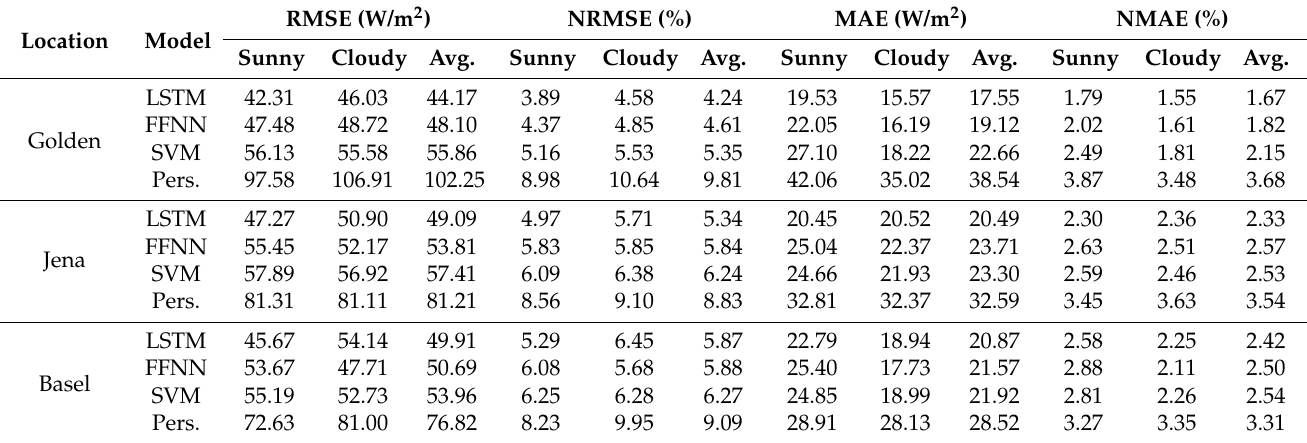
Table A1. The obtained results for the proposed hybrid model and other models for the training set. Location Model